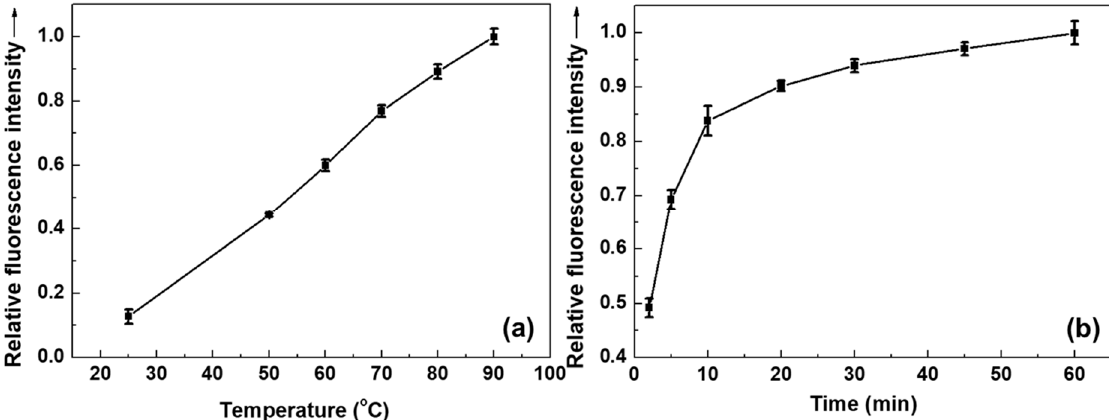
Figure 6. Relative fluorescence intensity of PP MPs stained with S-FN/Tween 20 at different staining temperatures ( a ) and times ( b ). Staining conditions: dye/surfactant = 1 g/L; dye/MP = 2.5 wt%; MP/aqueous solution = 1 g/L. The staining time is 60 min for ( a ), and the staining temperature is 80 °C for ( b ).